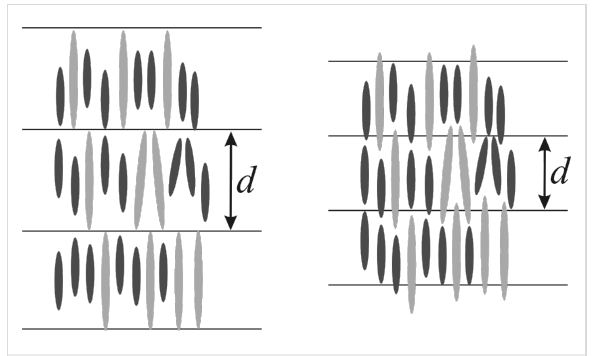
Figure 1: Smectic A phase of a mixture of two mesogens differing strongly in molecular length. Left: The layer spacing corresponds to the length of the long mesogen; no out-of-layer fluctuations occur. This leads to a lot of unfavorable free volume. Right: By reducing the smectic translational order the molecules are now densely packed. This leads to extensive out-of-layer fluctuations. Reproduced after